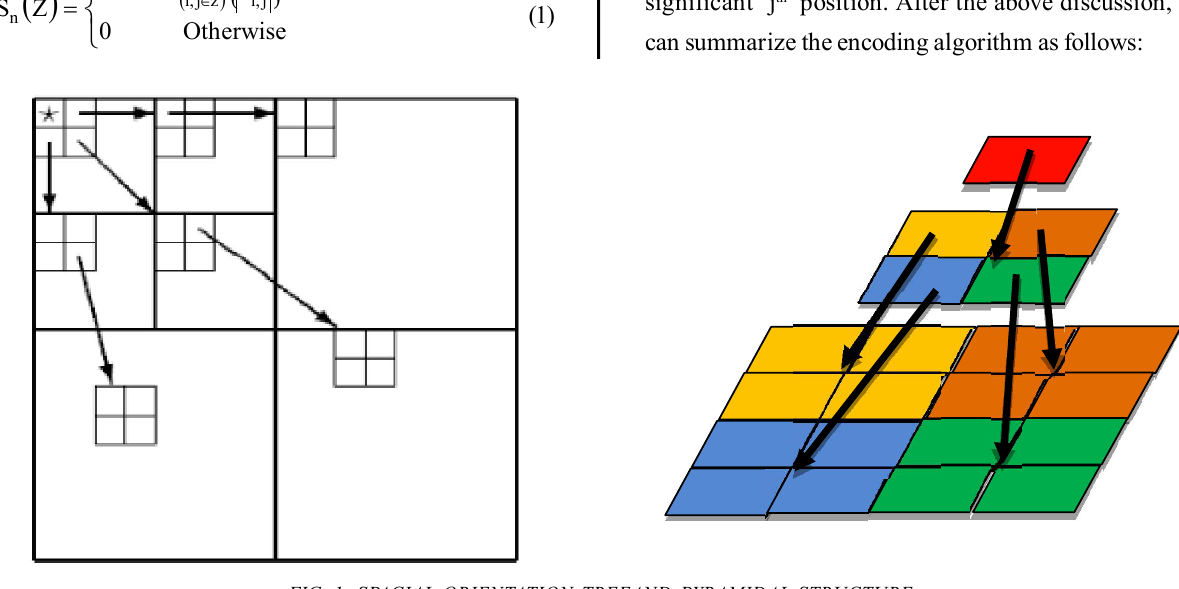
FIG. 1. SPACIAL ORIENTATION TREEAND PYRAMIDAL